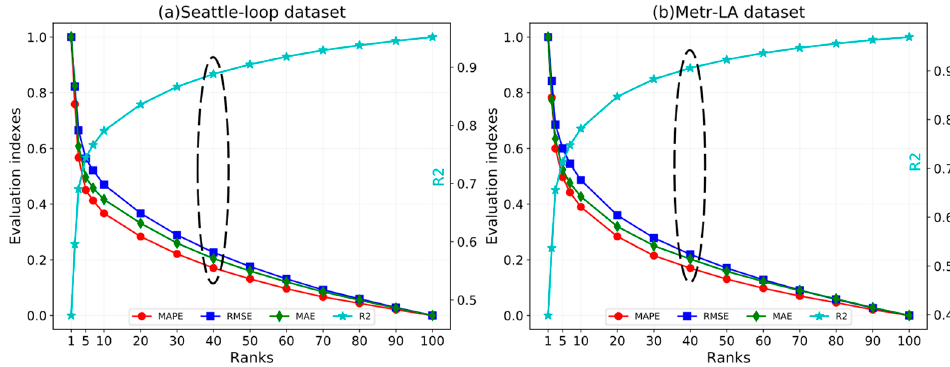
Figure 7. Impact of ranks on the evaluation metrics of the ST-CRMF model.